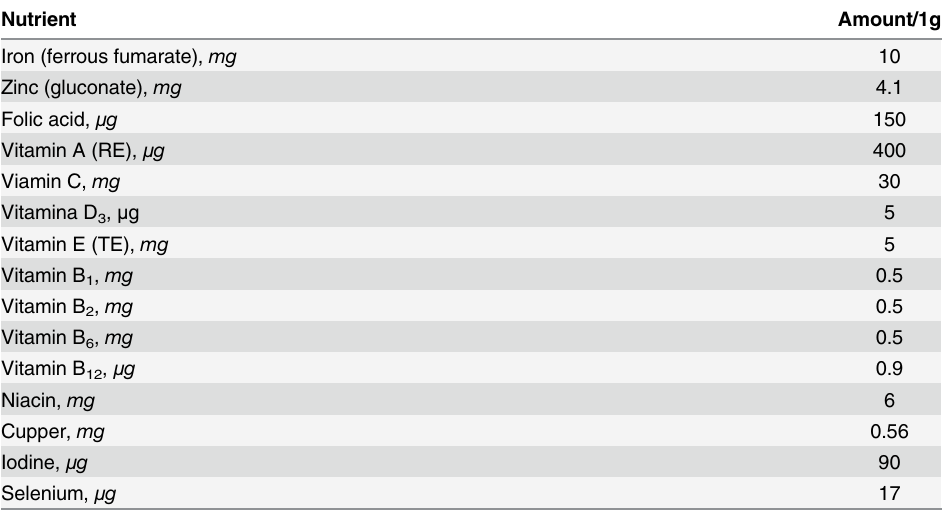
Table 1. Nutrient composition of the MNP used in the ENFAC Study a .